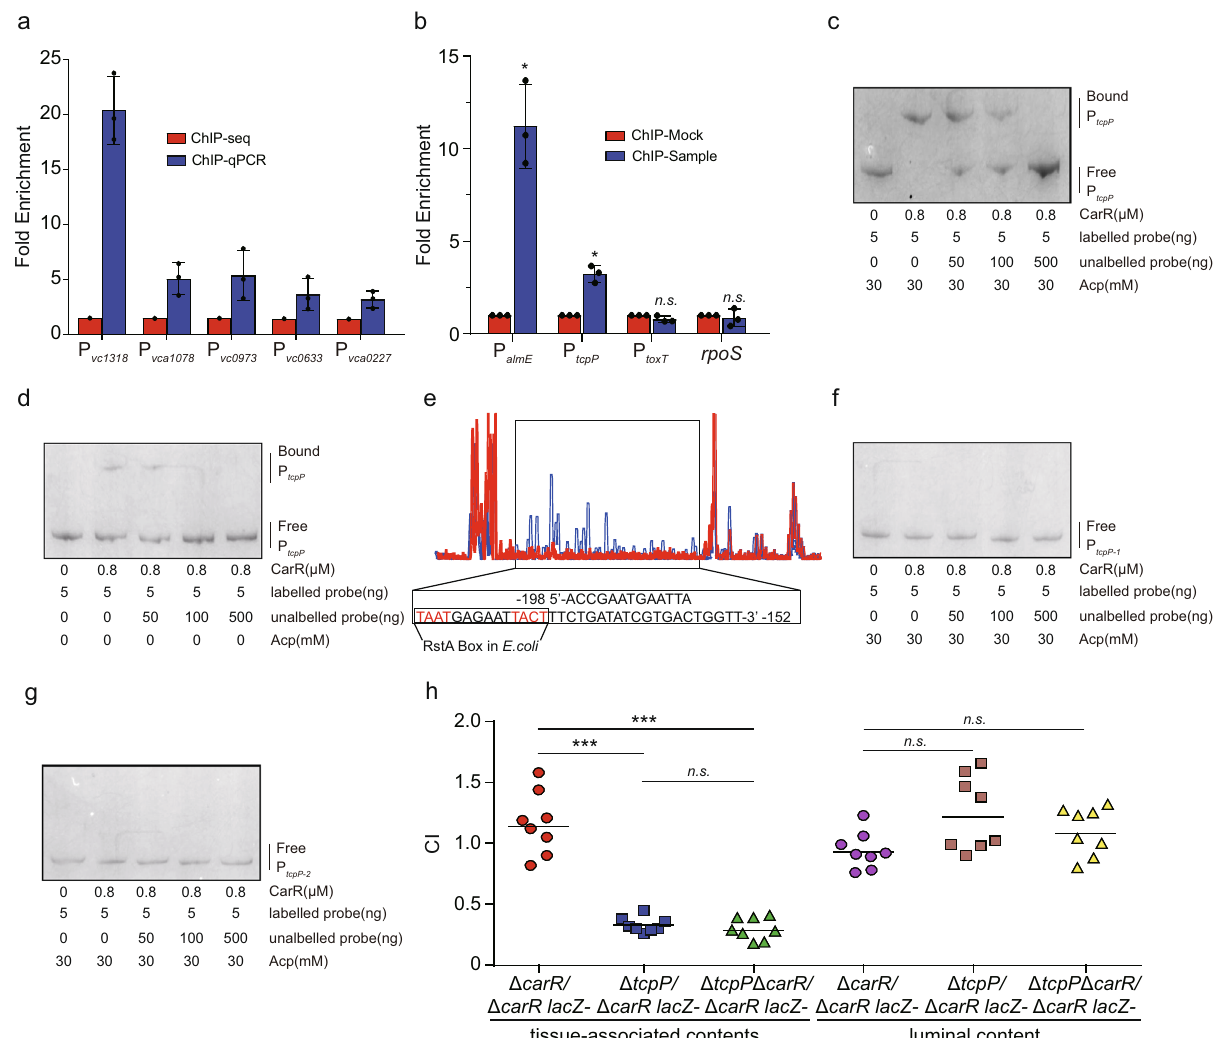
Fig. 5 CarR modulates virulence gene expression by directly regulating TcpP. a ChIP-seq results validation by ChIP-qPCR. Fold enrichment of P vc1318 , P vca1078 , P vc0973 , P vc0633 , and P vca0227 in CarR-ChIP samples, as measured by qPCR. b Fold enrichment of P almE , P tcpP , and P toxT in CarR-ChIP samples, as measured by qPCR. P almE served as a positive control, and rpoS and P toxT served as negative controls. Data are presented as mean ± SD ( n = 3). c CarR binds to a motif in the tcpP promoter region. The protected region shows a signi fi cantly reduced peak intensity (red) pattern compared with those of control (blue). The identi fi ed RstA box in E. coli is shown in a box at the bottom of the fi gure. d , e CarR bound to P tcpP with ( d ) or without ( e ) 30 mM acetyl phosphate. f , g CarR bound to 45-bp motif deletion ( f ) and potential RstA box deletion ( g ) P tcpP with 30 mM Acetyl phosphate. h In vivo competition assay of Δ carR , Δ tcpP , and Δ tcpP Δ carR in luminal contents and tissue-associated contents ( n = 8). CI is de fi ned as the output ratio of Δ tcpP and Δ tcpP Δ carR to Δ carR lacZ - divided by the input ratio of Δ tcpP and Δ tcpP Δ carR to Δ carR lacZ − . Each symbol represents the CI in an individual mouse; horizontal bars indicate the median. Signi fi cance was determined by a two-sided Mann – Whitney U test ( h ) or two-tailed unpaired Student ’ s t test ( b ). * P ≤